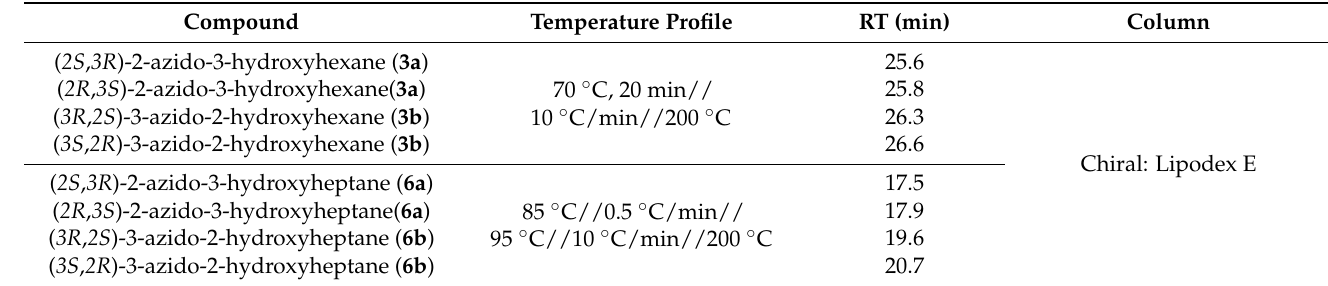
Detailed description of cascade reactions run at preparative scale, Figure S1: StyAB-catalysed epoxi- dation whole cells vs. cell-free extract, Figure S2: SDS-PAGE showing coexpression of StyAB with either Lk ADH or Ls ADH, Figure S3: StyAB-catalysed epoxidation at 40 and 80 mL scale, Figure S4: Oxygen consumption during the StyAB-catalysed epoxidation using whole cells vs. cell-free ex- tract, Figure S5: StyA residual activity, Figure S6: Comparison of different organic solvents for the StyAB-catalysed